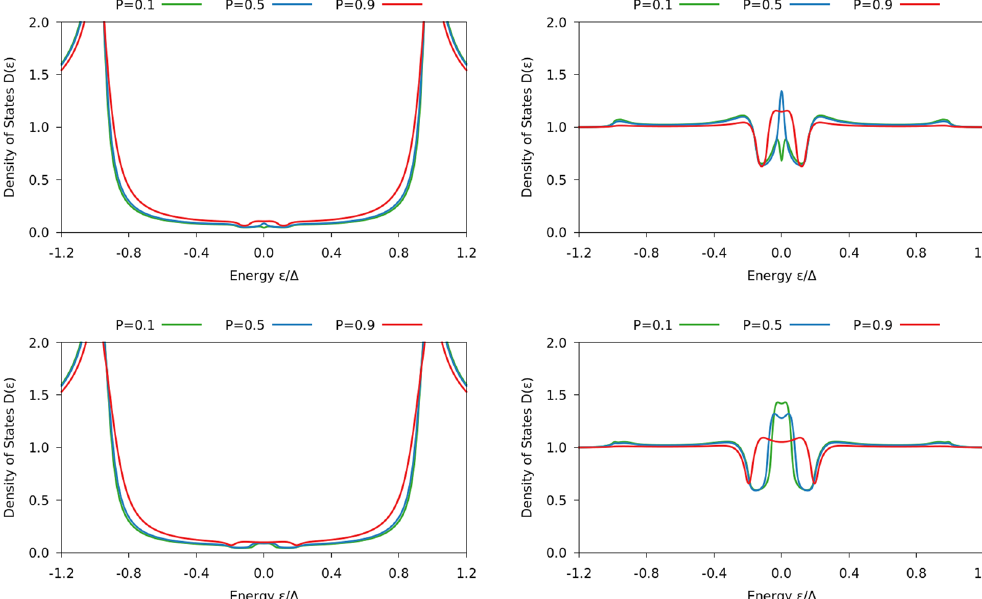
Figure 2. Plots of the DOS for an S/FI/N junction with L S = 3 ξ S and L N = ξ S as function of energy. The left column shows the results on the superconducting side of the interface, and the right column on the normal- metal side. The spin-mixing conductance G ϕ / G 0 is 0.75 in the top row and 1.25 in the bottom row, while the interface polarization P is written in the legend.